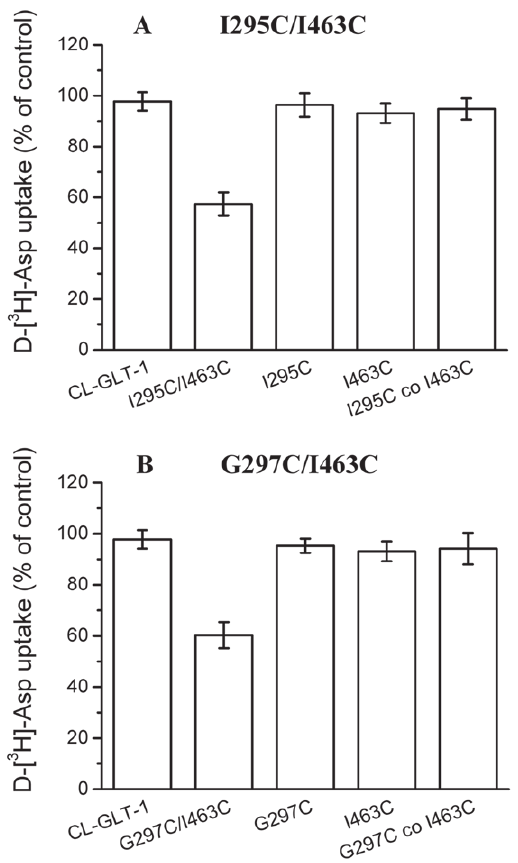
Figure 2. Effect of CuPh on the activity of cysteine mutants. HeLa cells expressing double cysteine mutants or the indicated control mutants, all in the background of CL-GLT-1, were preincubated in NaCl- containing medium with 200 m M CuPh for 5 min at room temperature, washed twice with choline chloride-containing solution, and subse- quently D-[ 3 H]aspartate transport was assayed. Co-expression of two single cysteine mutants in HeLa cells is marked by ‘‘co’’. The values shown represent the percentage of activity after treatment with 200 m M CuPh relative to that obtained after preincubation in the absence of CuPh. Values represent the mean 6 S.E. of at least three separate experiments each done in triplicate. ( A ) I295C/I463C double cysteine mutants and its control mutants. ( B ) G297C/I463C double cysteine mutants and its control mutants.